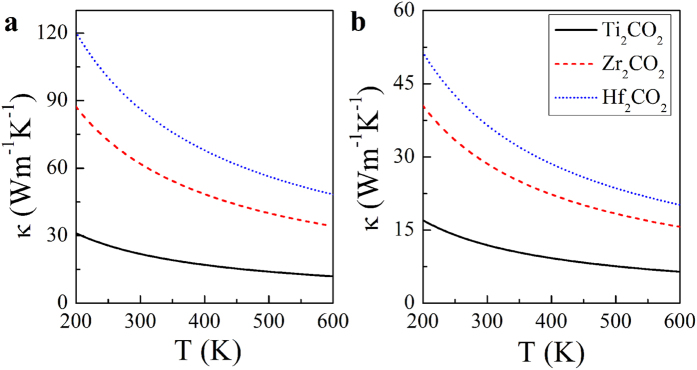
The temperature dependence of the thermal conductivities of the M2CO2 (M = Ti, Zr, Hf) MXenes.(a) The temperature dependence of the thermal conductivities of the M2CO2 (M = Ti, Zr, Hf) MXenes along the armchair direction. The Ti2CO2, Zr2CO2 and Hf2CO2 thermal conductivities are denoted in black solid, red dashed and blue dotted lines, respectively. (b) The temperature dependence of the thermal conductivities of the M2CO2 (M = Ti, Zr, Hf) MXenes along the zigzag direction.